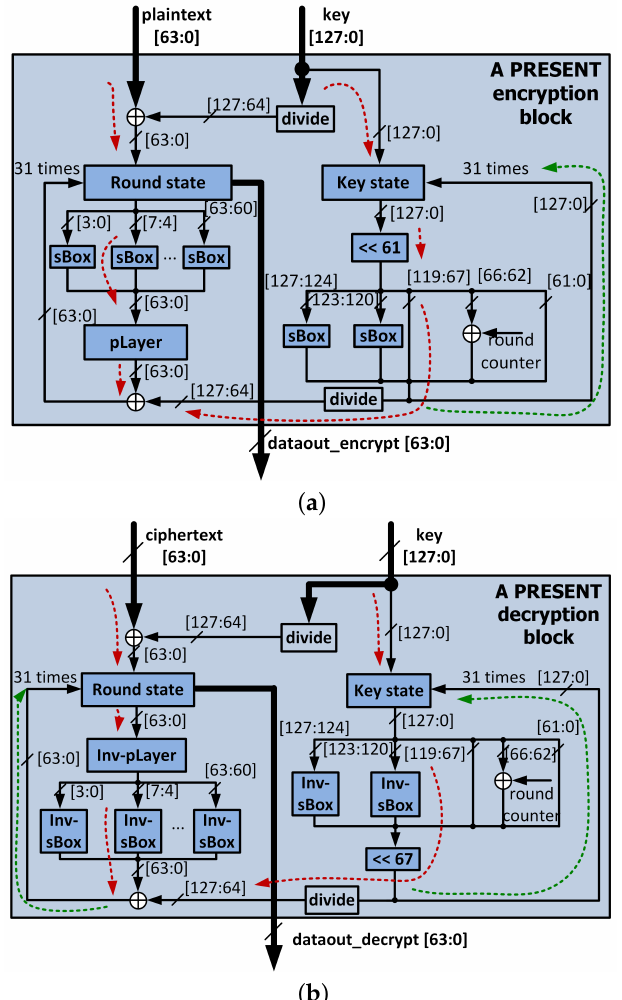
Figure 5. Hardware architecture of PRESENT ( a ) encryption and ( b )